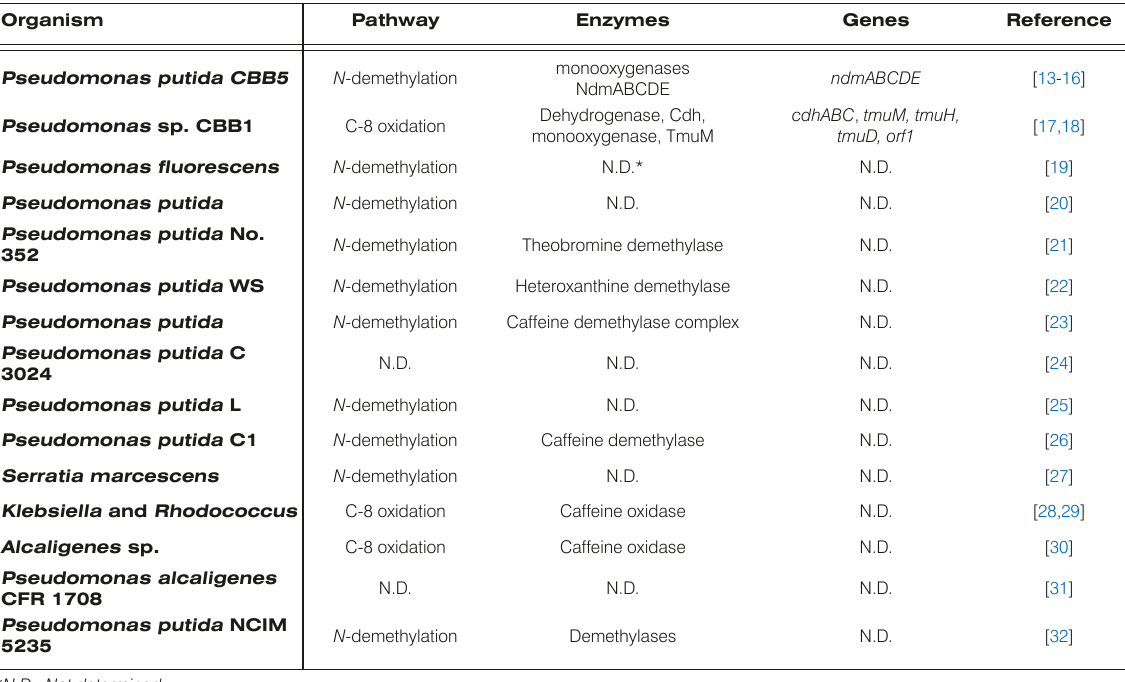
Table 1. Compilation of bacteria capable of degrading caffeine and their attributes.